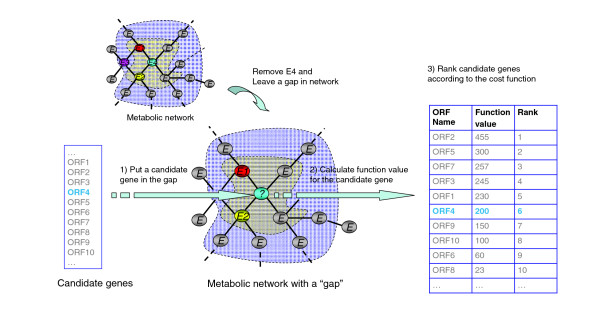
'Fit' test of a candidate gene in a network gap. We use a self-consistent test in which a known gene E4 is removed from the network, leaving a gap in its place. We then: 1, put candidate genes in the gap one by one; 2, determine the function value for every candidate gene (Equations 1 to 3); and 3, rank all candidate genes based on their function values. In the figure we show an example when the correct gene E4 was ranked as number 6.